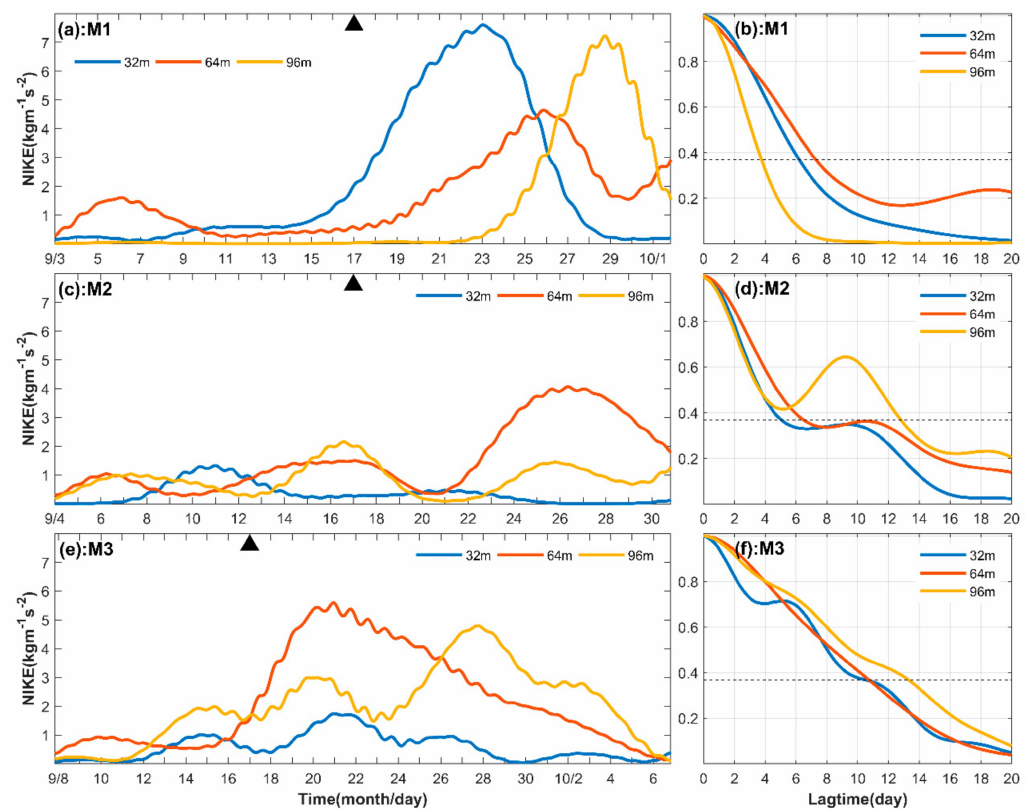
Figure 6. Near-inertial kinetic energy at the depths of 32 m, 64 m, and 96 m for M1 ( a ), M2 ( c ), and M3 ( e ), and the autocorrelation of near-inertial kinetic energy at the depths of 32 m, 64 m, and 96 m for M1 ( b ), M2 ( d ), and M3 ( f ). The approach of typhoon Noul is denoted by the triangles in ( a , c , e